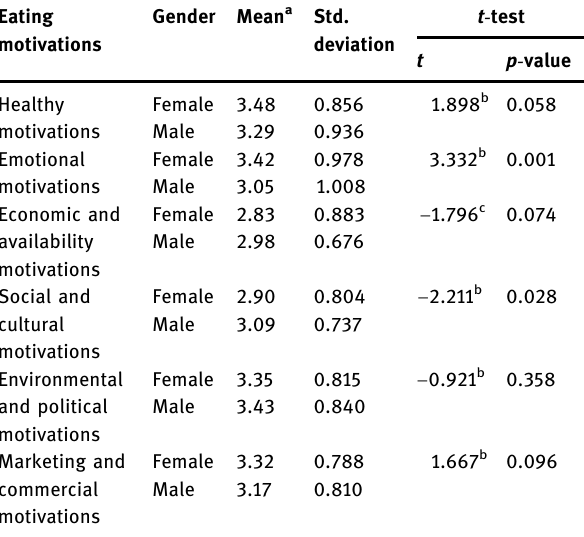
Table 4: Participants ’ eating motivations with respect to gender.